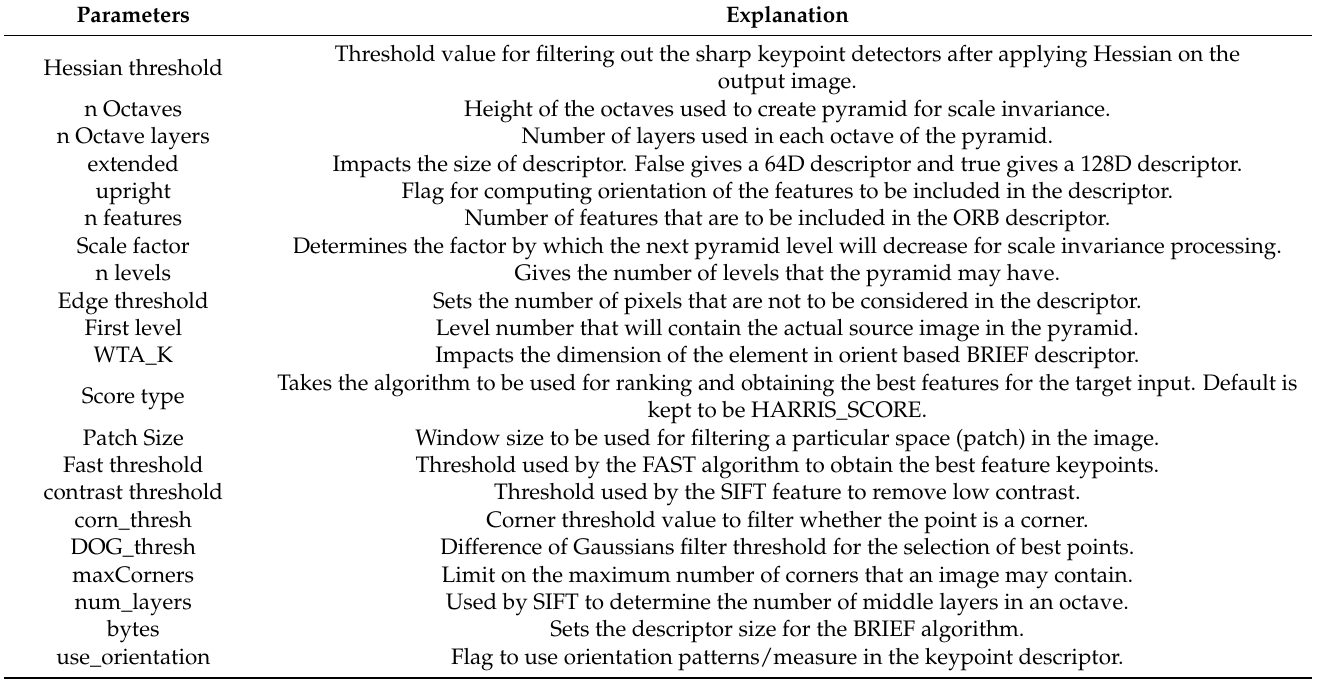
Table 1. Cv2 hyper parameters used to instantiate cv2 algorithms for the analysis of the